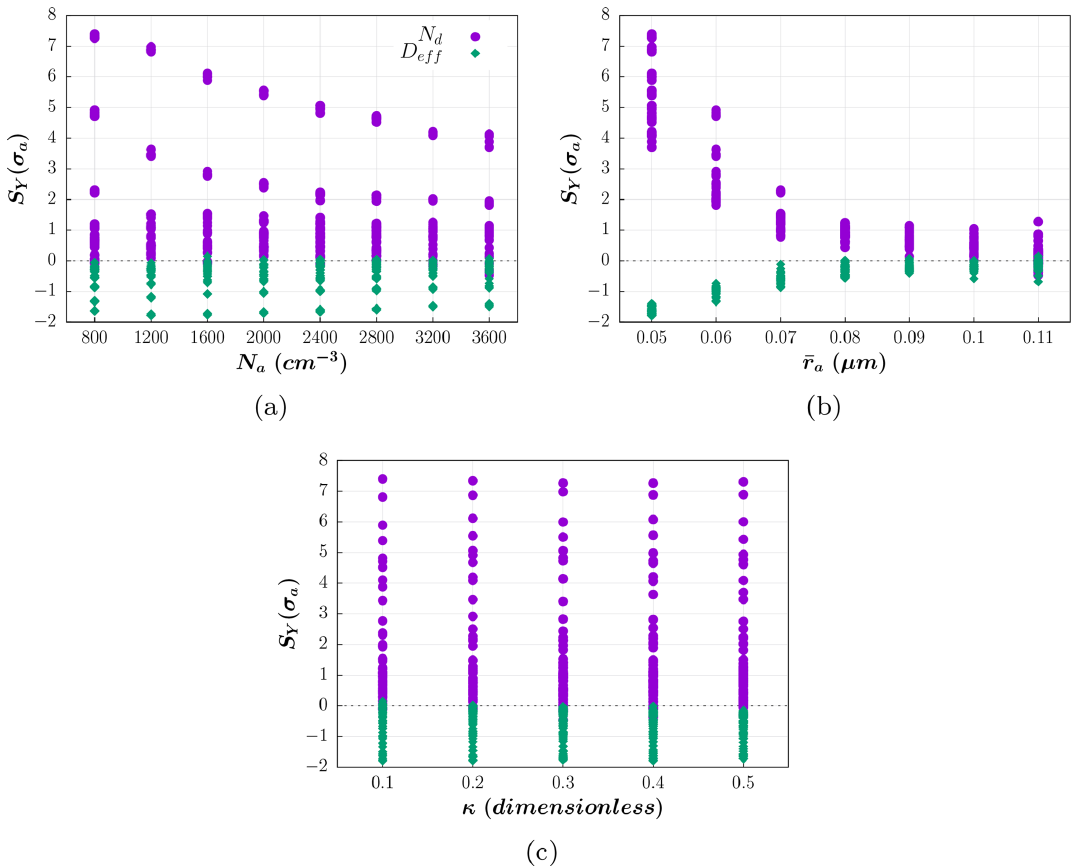
Figure 6. Sensitivities of the droplet number concentration and effective diameter to the geometric standard deviation of the PSD, S Y (σ a ) , as a function of (a) the aerosol number concentration (cm − 3 ), (b) the median radius of the PSD (µm) and (c) the aerosol hygroscopicity